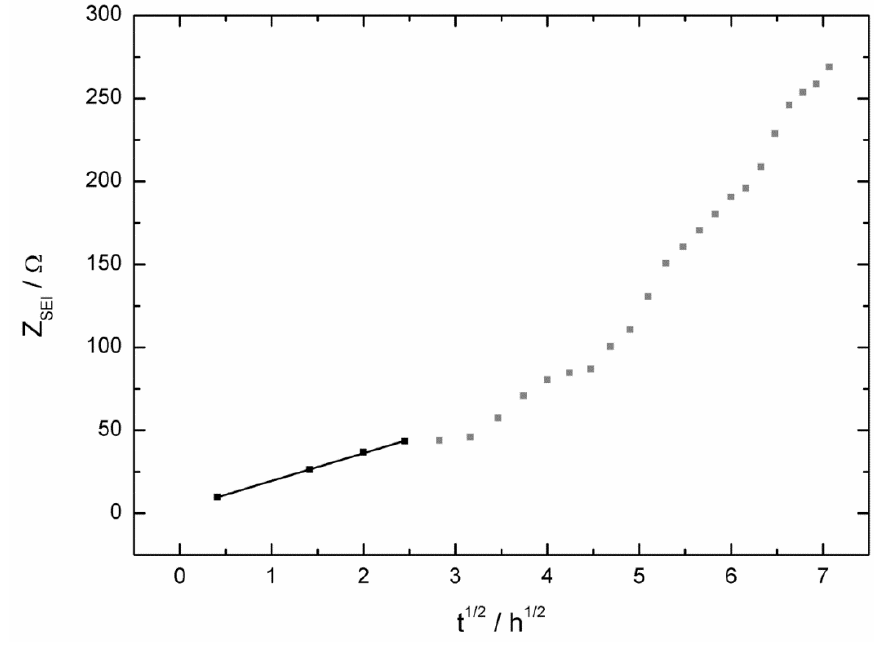
Figure 13. Variation of the interphase resistance Z LiDFOB in EC:DEC (3:7, by wt.)